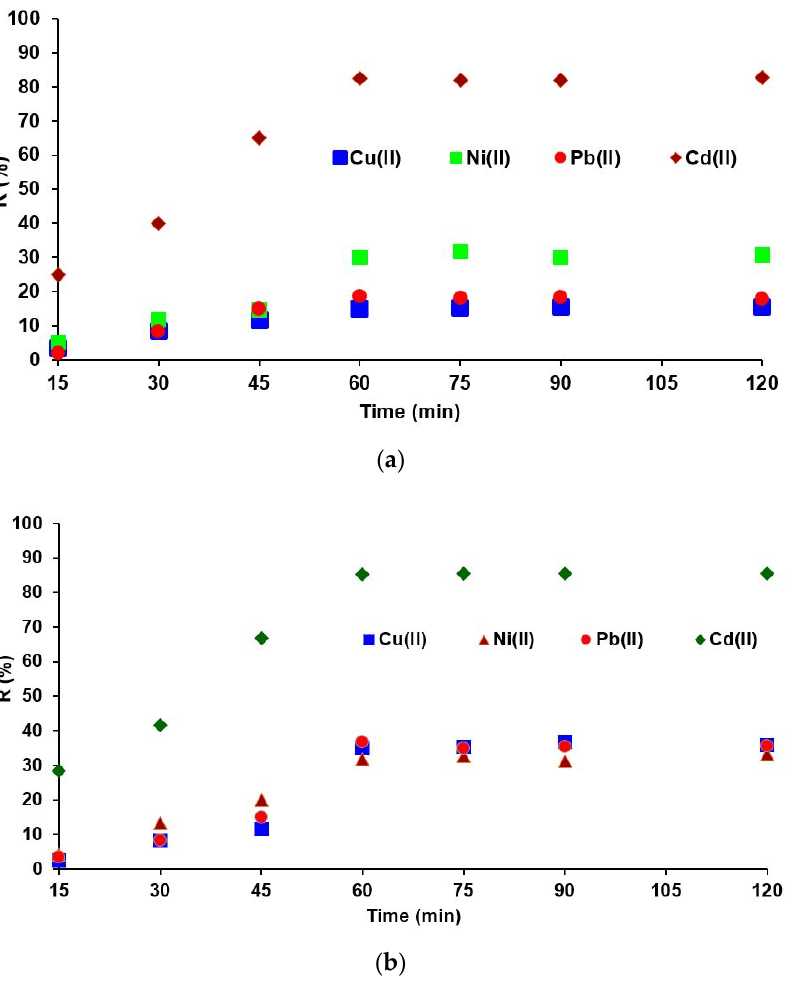
Figure 5. Removal of M 2+ as a function of contact time on ( a ) IRA 402-DR23 and ( b ) XAD7HP-DR23.